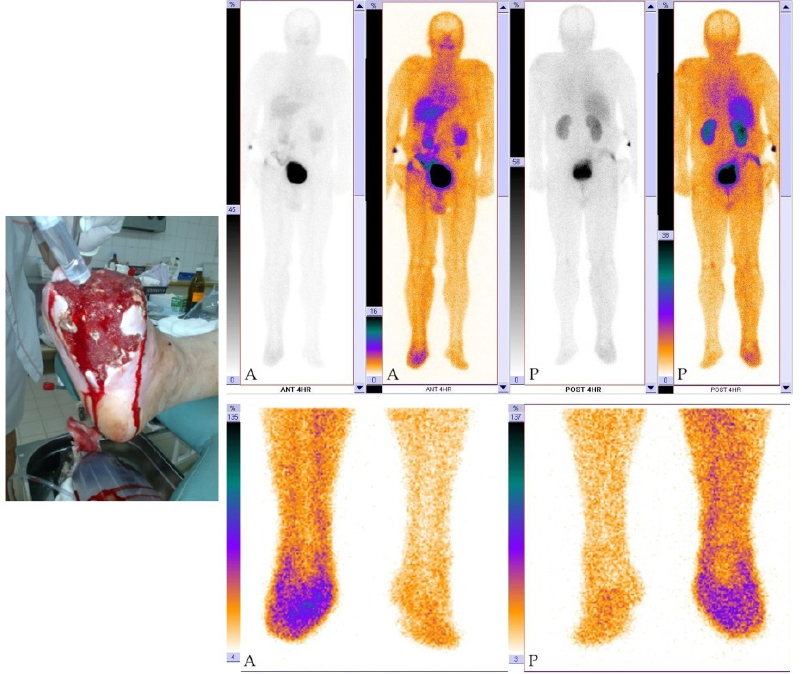
Figure 8. Morphological image of the foot infected in course of the DFS and whole-body [ 99m Tc]Tc- CIP scintigraphy of a patient with infected diabetic right foot (A-anterior and P-posterior) in course of the DFS. Intense radiotracer uptake in the bladder, liver, kidneys, as well in the infected part of the right foot.